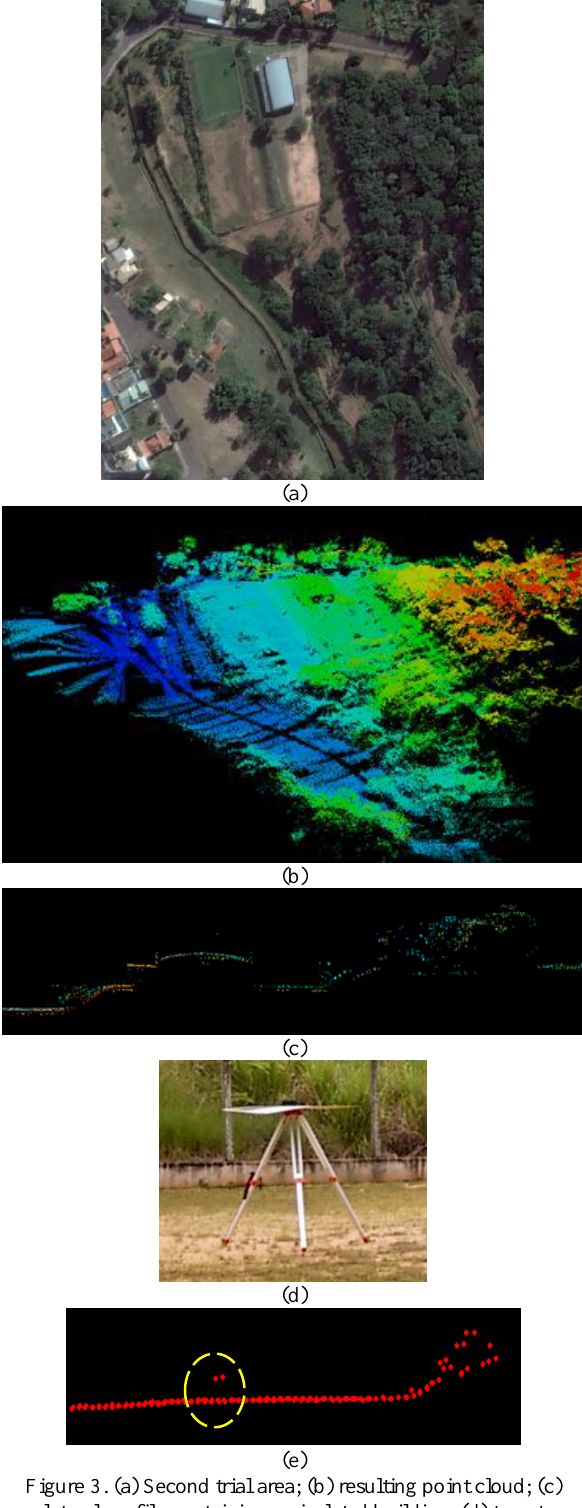
Figure 3. (a) Second trial area; (b) resulting point cloud; (c) lateral profile containing an isolated building; (d) target example, and (e) its identification in point